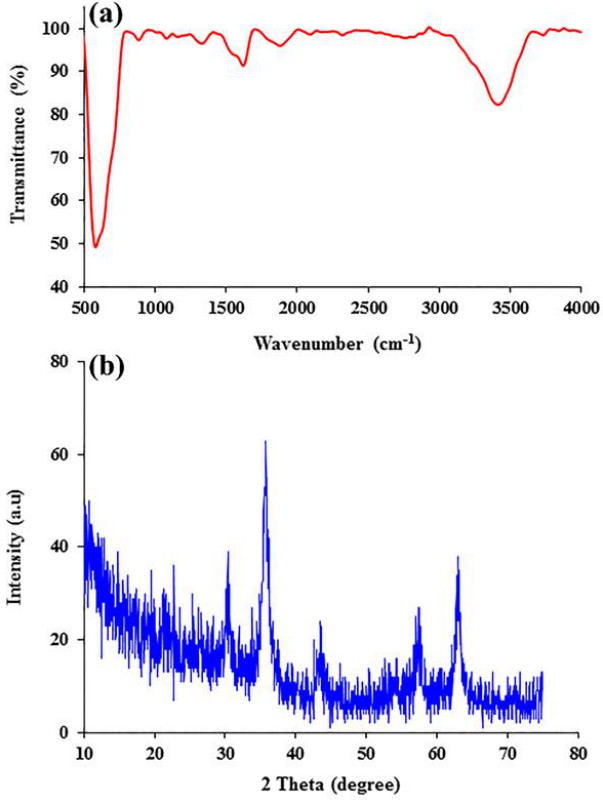
Figure 2. FTIR spectrum ( a ) and XRD pattern ( b ) of Fe 3 O 4 NPs.